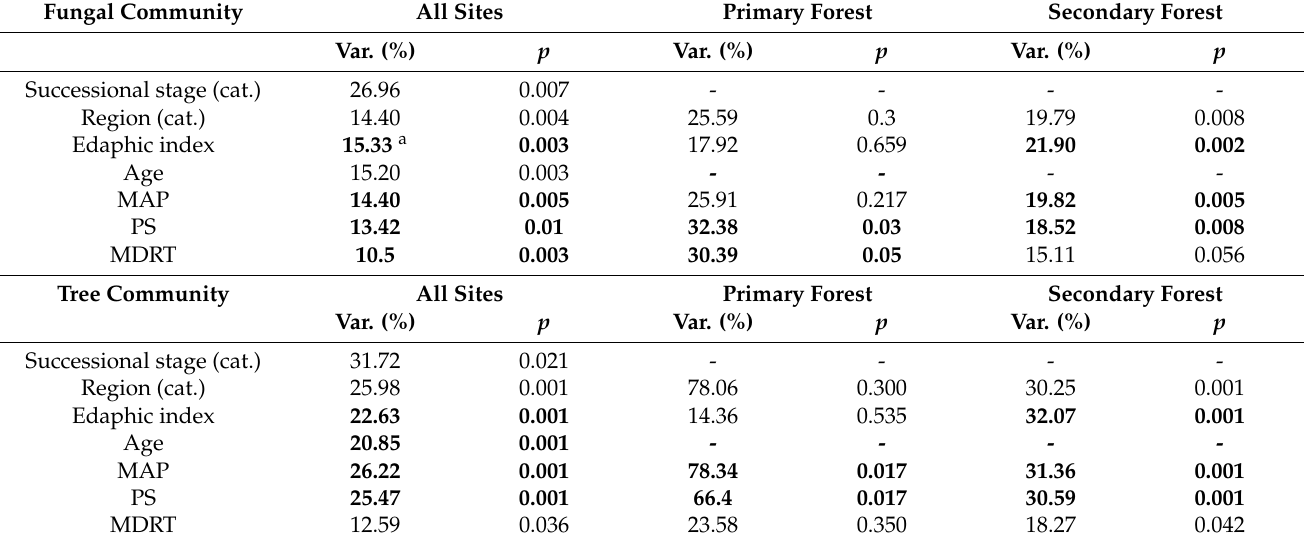
Table 1. Proportion of variation in fungal and tree community composition explained by successional stage and region (categorical) and edaphic and climatic (continuous) variables as explained in the text. Abbreviations: MAP: mean annual precipitation, MDRT: mean diurnal range of temperature, PS: precipitation seasonality. Fungal Community All Sites Primary Forest Secondary Forest Var. (%) p Var. (%) p Var. (%) p Successional stage (cat.) 26.96 0.007 - - - - Region (cat.) 14.40 - - MAP